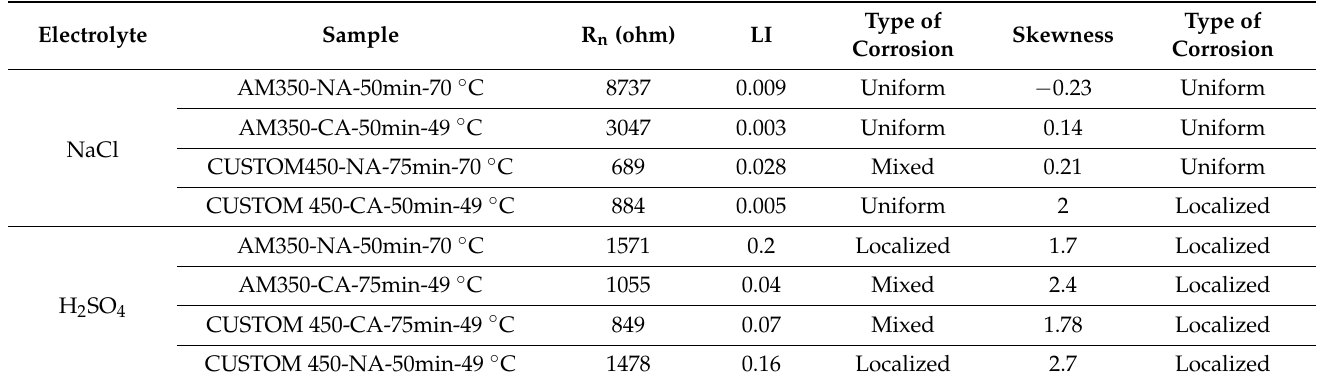
Table 3. EN statistical parameters from passivated CUSTOM 450 and AM 350 stainless